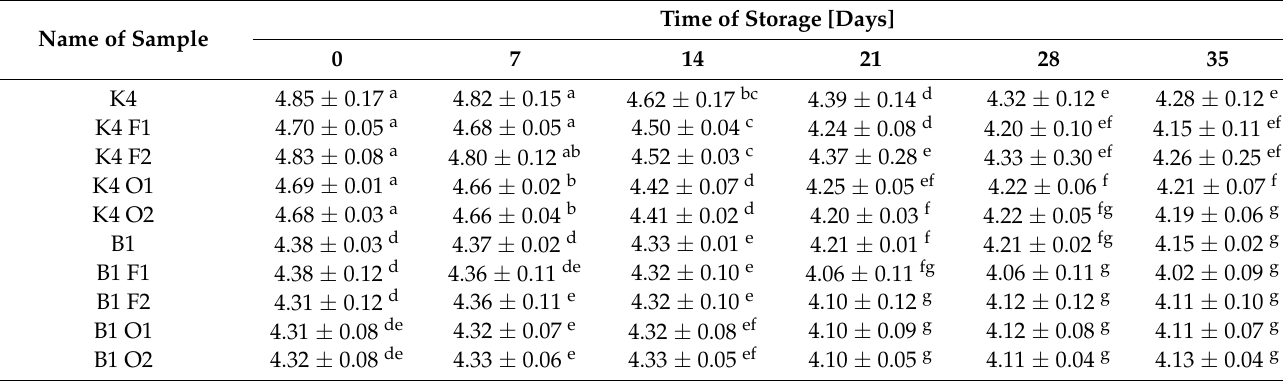
Table 1. Changes in pH values ± SD in fermented milk samples during